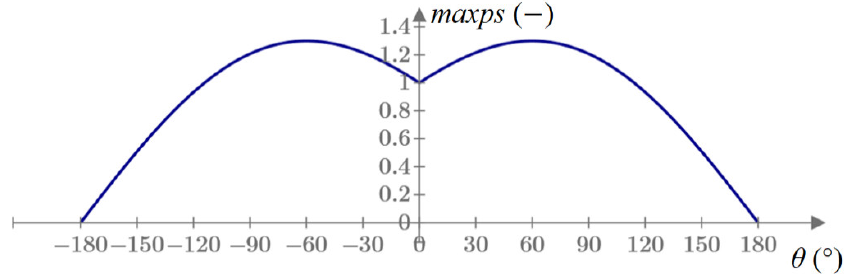
Figure 3. Maximum principal stresses around Griffith’s crack in Mode I.